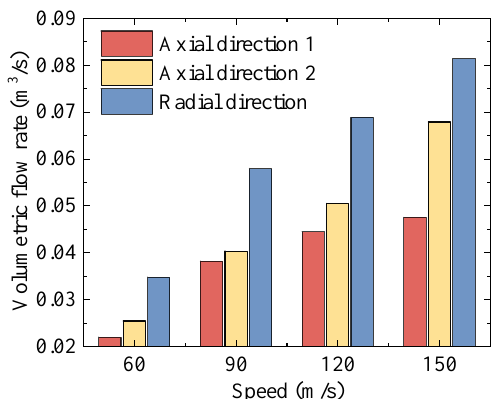
Figure 7. Streamline in the axial cross-section: ( a ) Simulation of a single gear; ( b ) Simulation of a gear pair.